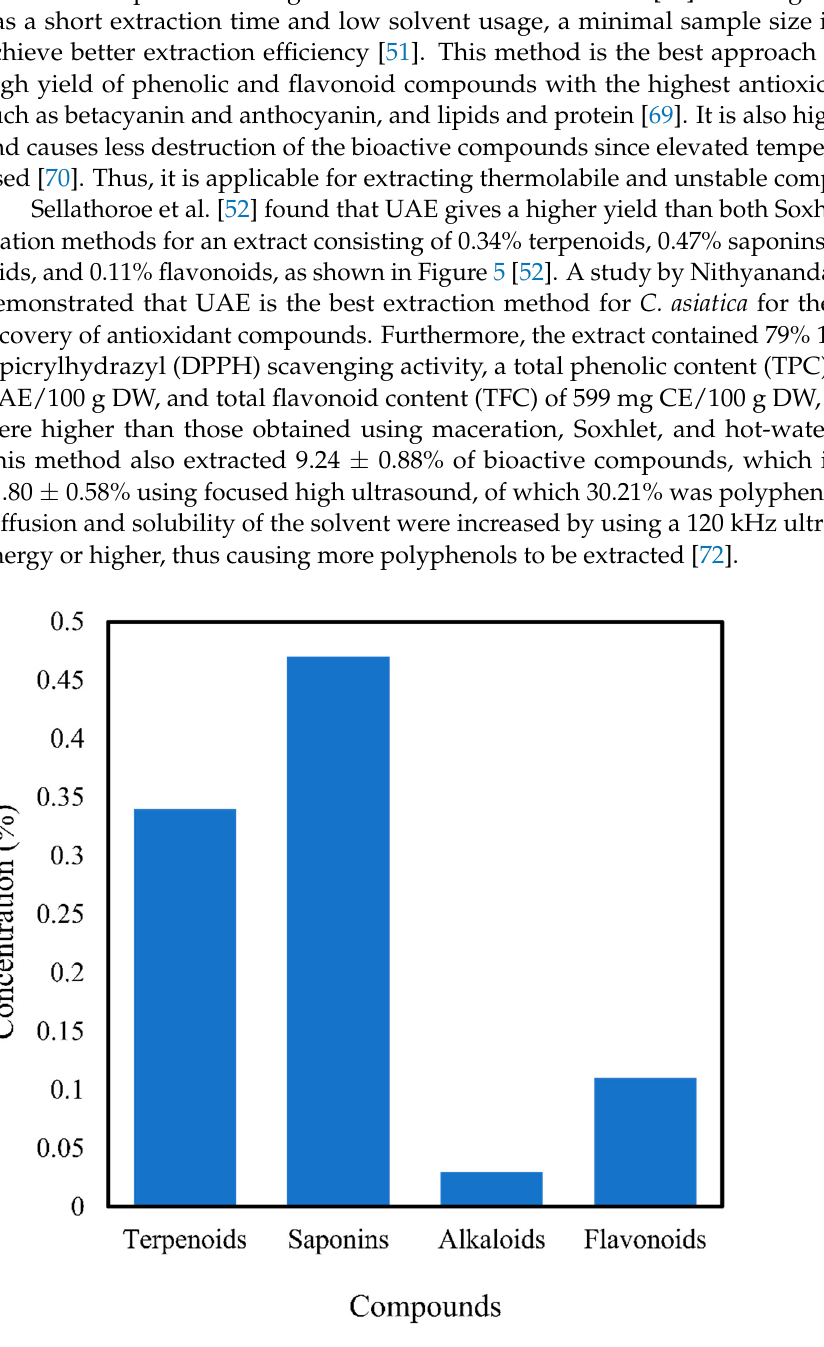
Figure 5. Bioactive compounds extracted using the ultrasonic extraction method of Sellathoroe et al.